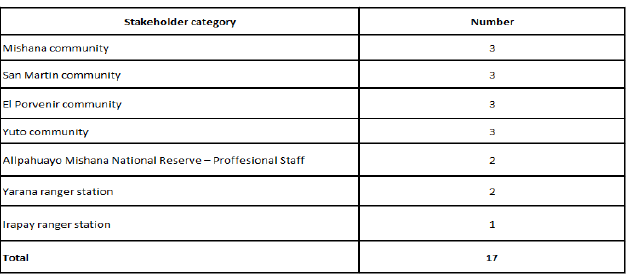
Table 1: Stakeholders selected for the assessment